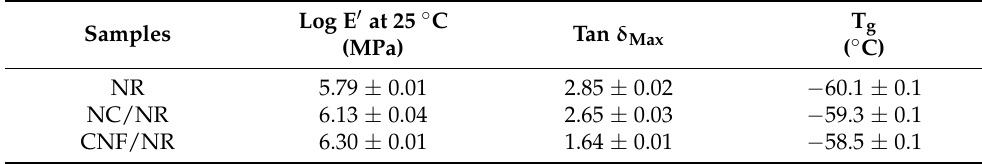
Table 3. Storage Modulus (log E (cid:48) ) at 25 ◦ C, Maximum Tan δ Peak (Tan δ max ), and Glass Transition Temperature (T g ) of NR, NC/NR, and